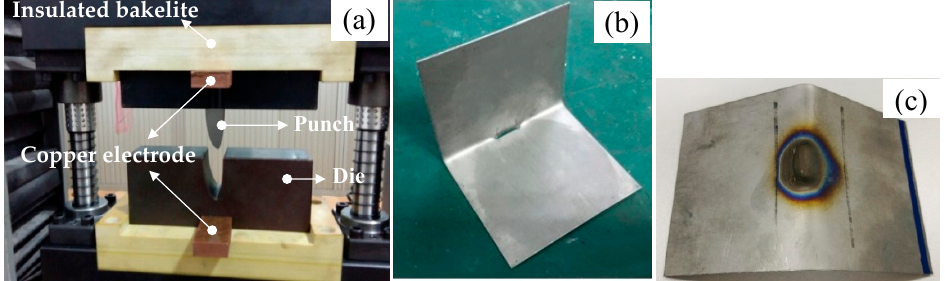
Figure 4. Electrically-assisted forming setup and firstly formed parts: ( a ) Forming setup, ( b ) no pulse current, ( c ) 10.9 A/mm 2.